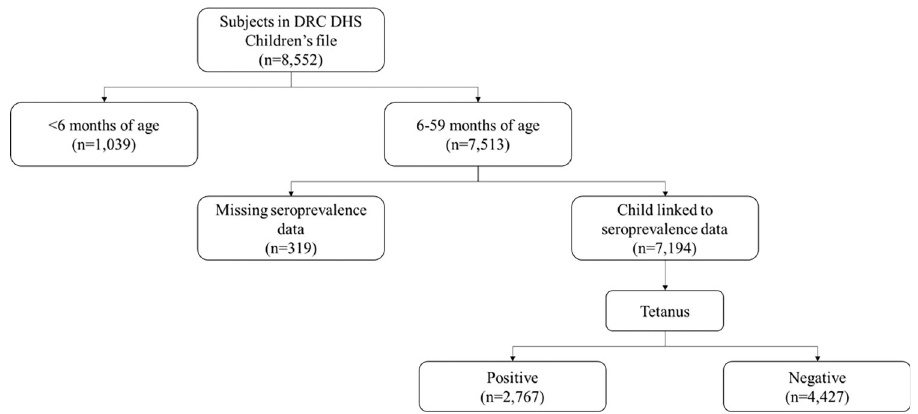
Fig 1. Attrition table. Study inclusion for assessment of tetanus seroprevalence among 6- to 59-month-old EDS-RDC II respondents (unweighted).